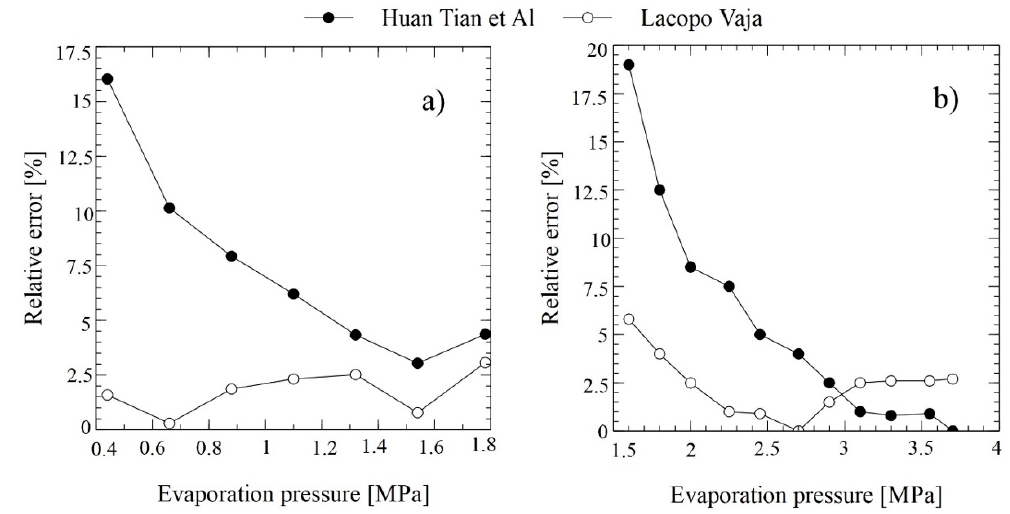
. Figure 3. Relative error presented of the RORC model with respect to research performed by Lacopo [29] and Huan Tian et al. [30], ( a ) Refrigerant R-11, ( b ) Refrigerant R-134a.